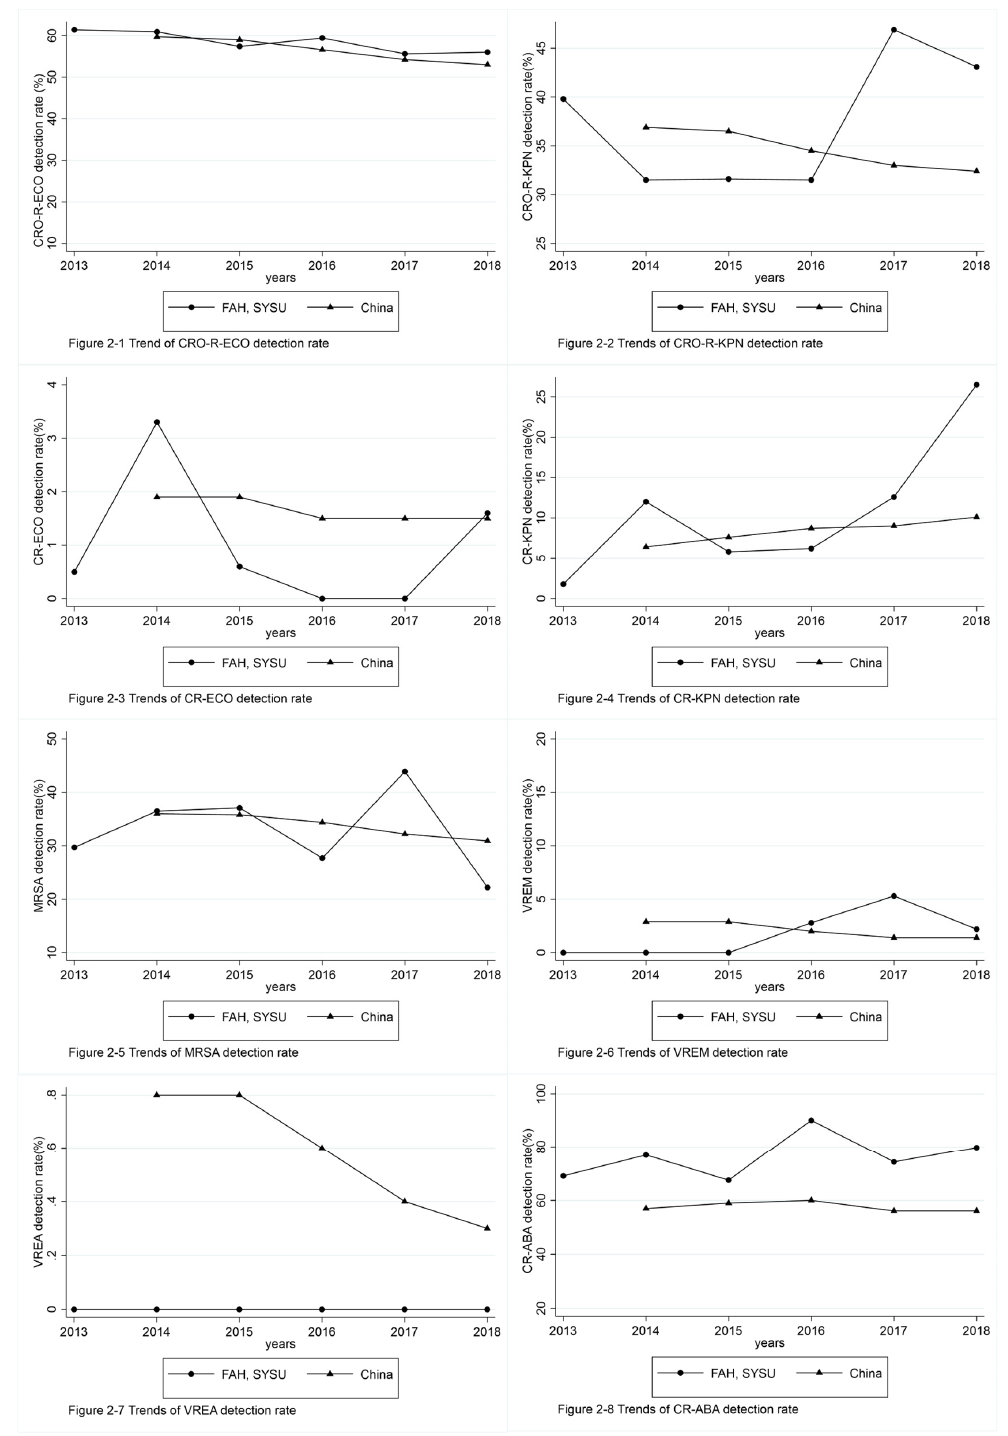
Figure 2. Comparison between the detection rate of multiple antibiotic-resistant bacteria among patients with bloodstream infection at FAH, SYSU from 2013 to 2018, and nationally reported detection rates for multiple antibiotic-resistant bacteria between 2014 and 2018. FAH, SYSU: First Affiliated Hospital of Sun Yat-sen University. CRO-R-ECO: ceftriaxone-resistant Escherichia coli , CRO-R-KPN: ceftriaxone-resistant Klebsiella pneumoniae , CR-ECO: carbapenem-resistant Escherichia coli , CR-KPN: carbapenem-resistant Klebsiella pneumoniae , MRSA: methicillin-resistant Staphylococcus aureus , VREM: vancomycin-resistant Enterococcus faecium , VREA: vancomycin-resistant Enterococcus faecalis , CR-ABA: Acinetobacter baumannii .